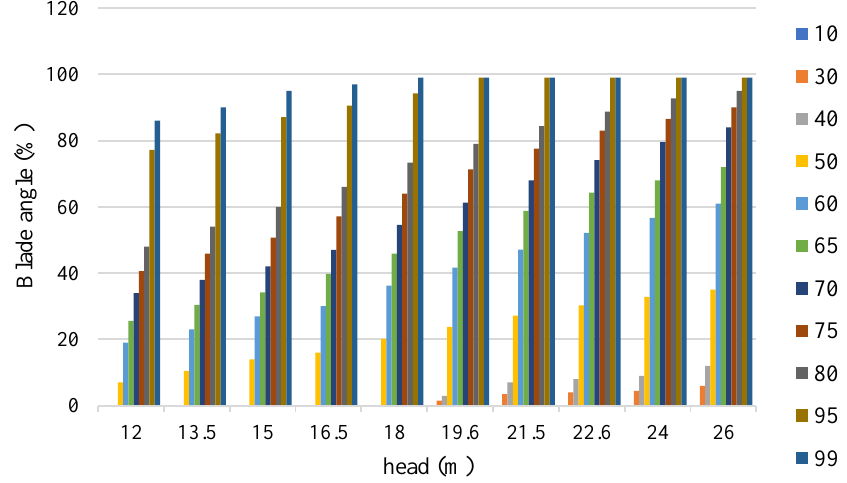
Figure 9. The cam relationship of this paper.